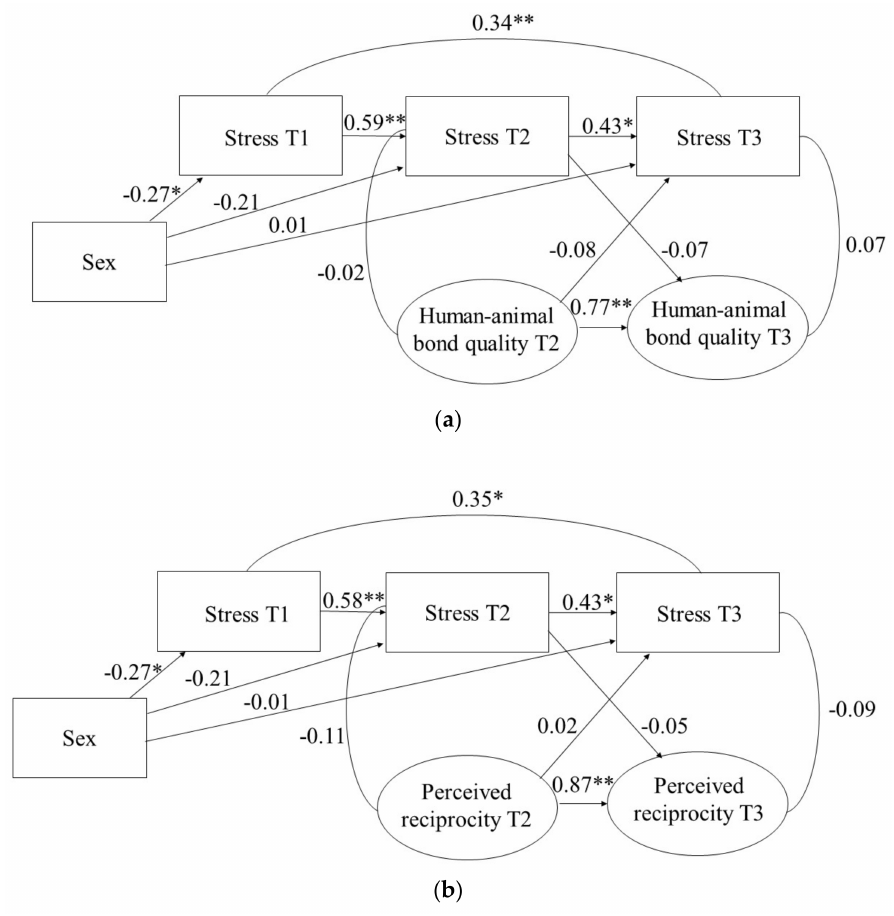
Figure 1. ( a ) CLPM for Stress and Human–Animal Bond Quality, and Sex as a Covariate. ( b ) CLPM for Stress and Perceived Reciprocity, and Sex as a Covariate. Note. * p < 0.01 ** p <